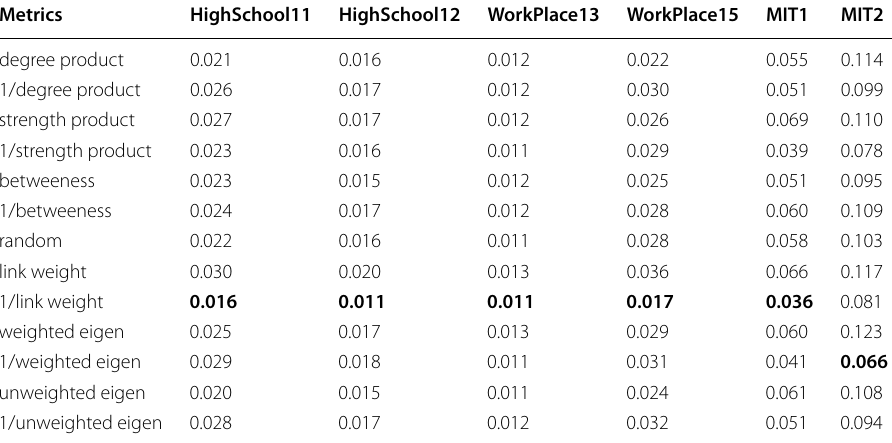
The lowest average prevalence value for each dataset is highlighted in bold